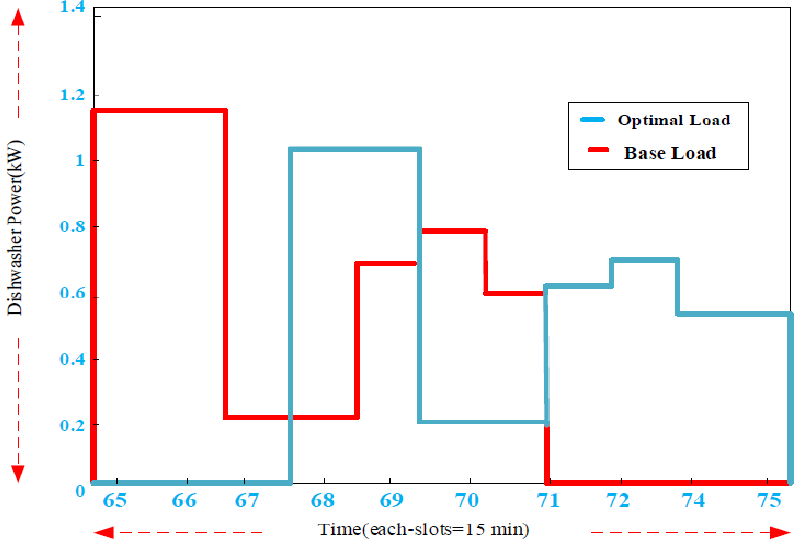
Figure 12. Comparison of dishwasher consumption profile before and after applying the proposed method.